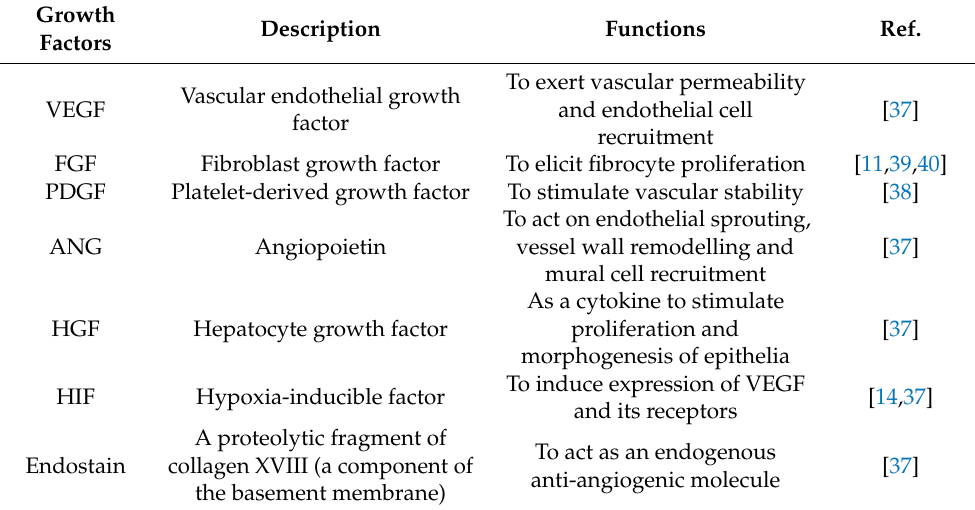
Table 2. Representative growth factors for angiogenesis in the